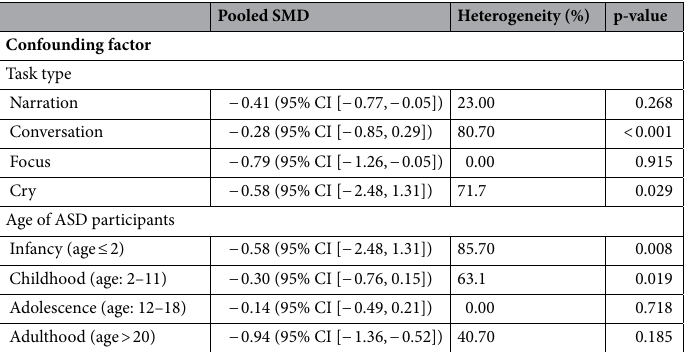
Pooled SMD Heterogeneity (%)